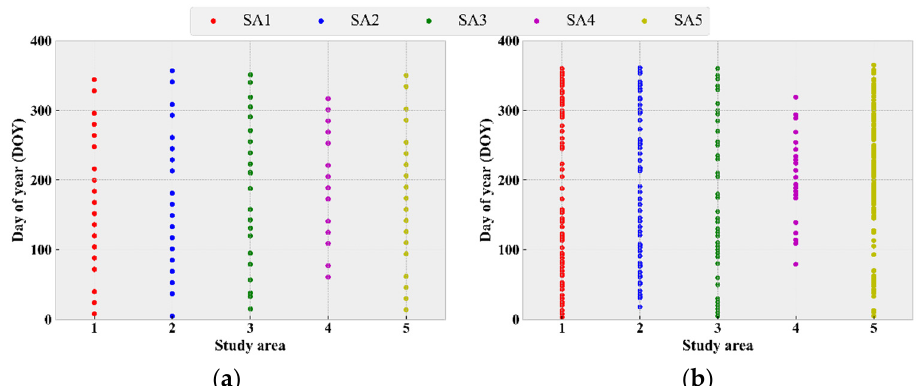
Figure 3. Temporal distribution of all available Landsat-8 ( a ) and Sentinel-2 ( b ) images with scene cloud coverage less than 20%.